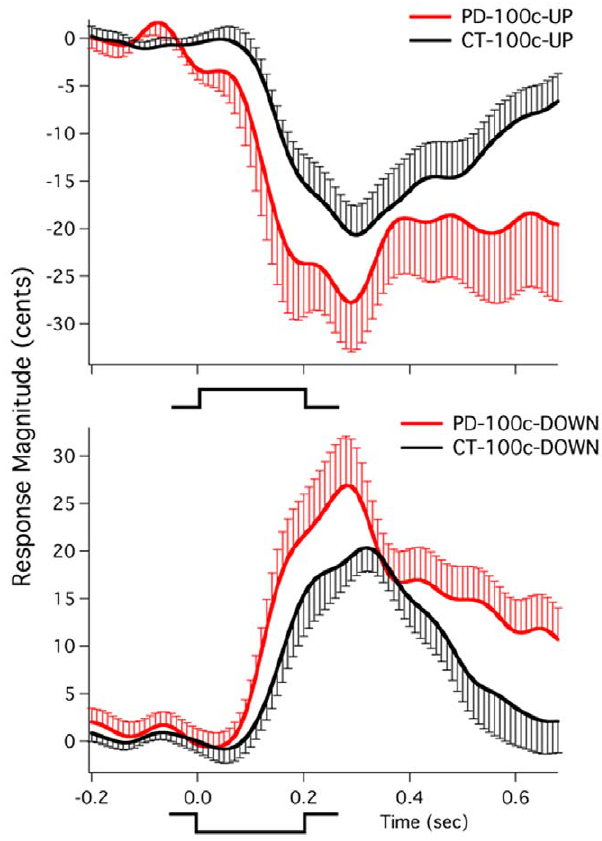
Figure 3. Grand-averaged vocal responses to upward (top) and downward (bottom) 100 cents perturbations across all PD and control subjects. See Figure 1 for details.